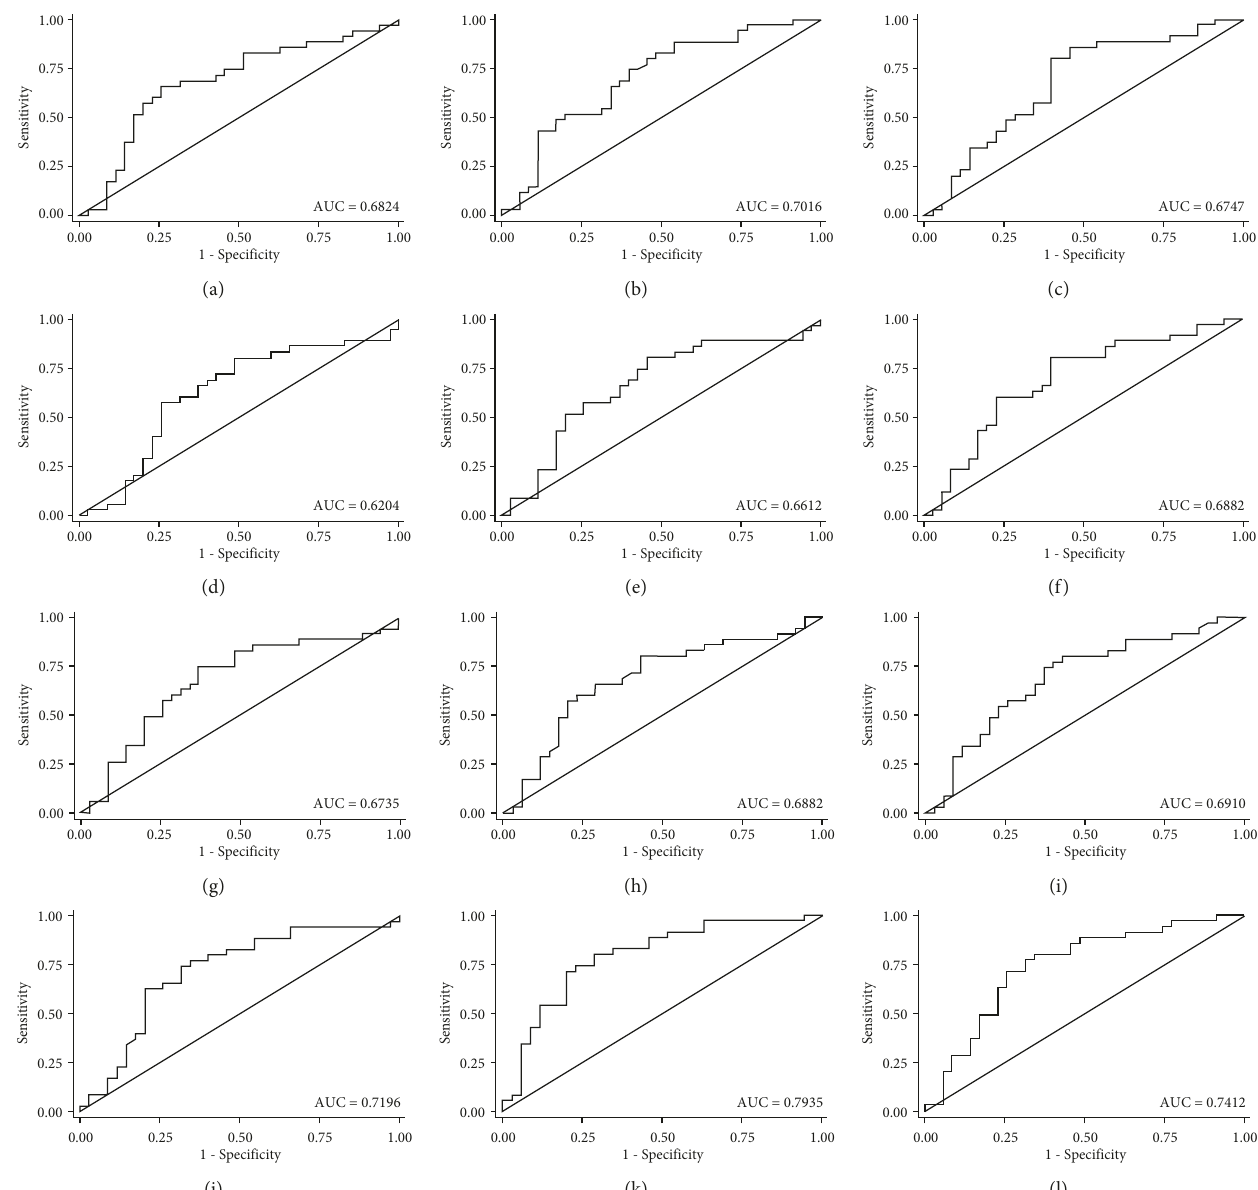
Figure 2: The receiving operating characteristics curve of single ratio index of angle parameter in differential diagnose of ectopia lentis. ((a) AODr250 (AUC � 0.682); (b) AODr500 (AUC � 0.701); (c) AODr750 (AUC � 0.675); (d) ARAr250 (AUC � 0.620); (e) ARAr500 (AUC � 0.661); (f) ARAr750 (AUC � 0.688); (g) TISAr250 (AUC � 0.674); (h) TISAr500 (AUC � 0.688); (i) TISAr750 (AUC � 0.691); (j) TIAr250 (AUC � 0.720); (k) TIAr500 (AUC � 0.794); (l) TIAr750 (AUC �